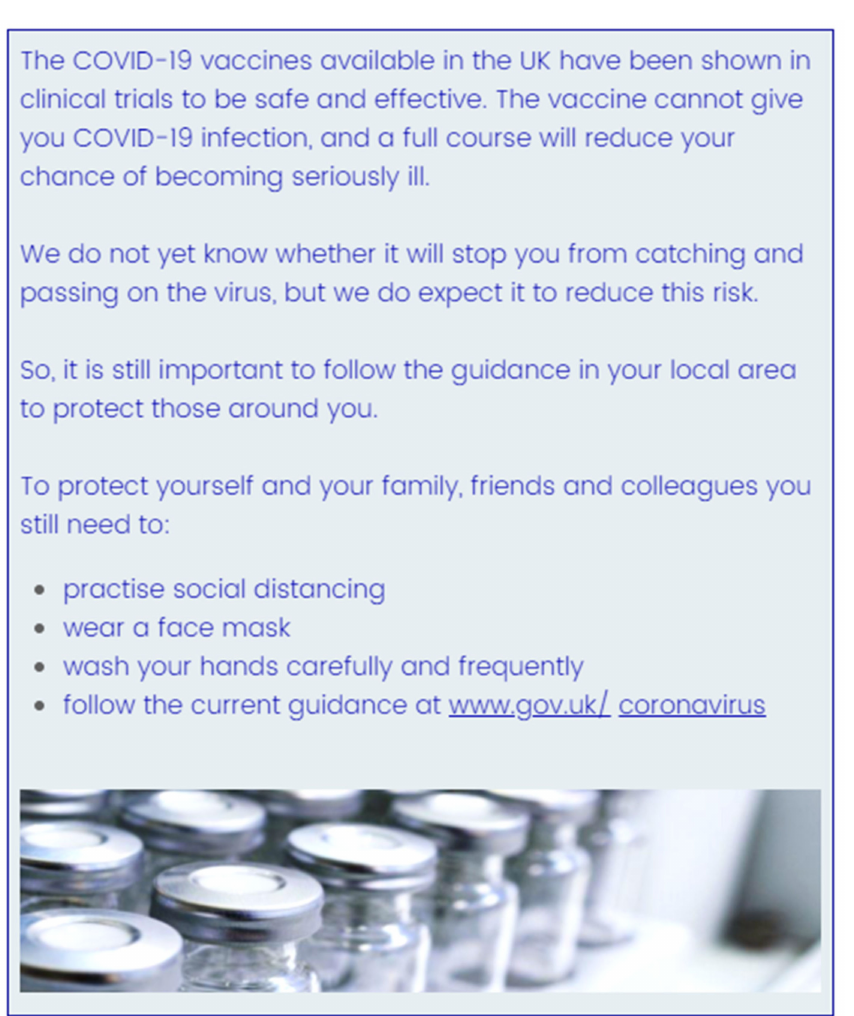
Figure 3. The Long Medium Caution message. Participants then completed the following measures (in order presented; full item wording can be found in Supplementary Material